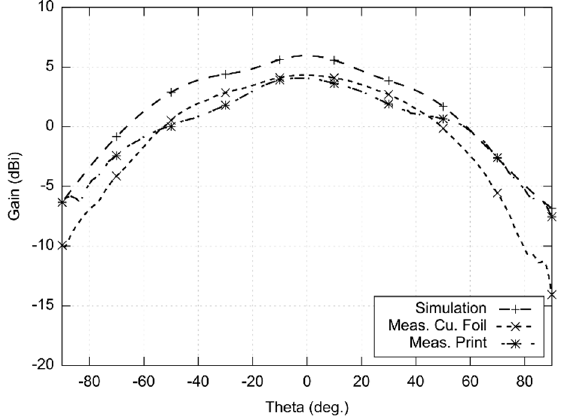
Figure 7. Simulated and measured radiation patterns (YZ plane) of the antenna designed for the 24 GHz ISM band (simulated and measured at 22.25 GHz).